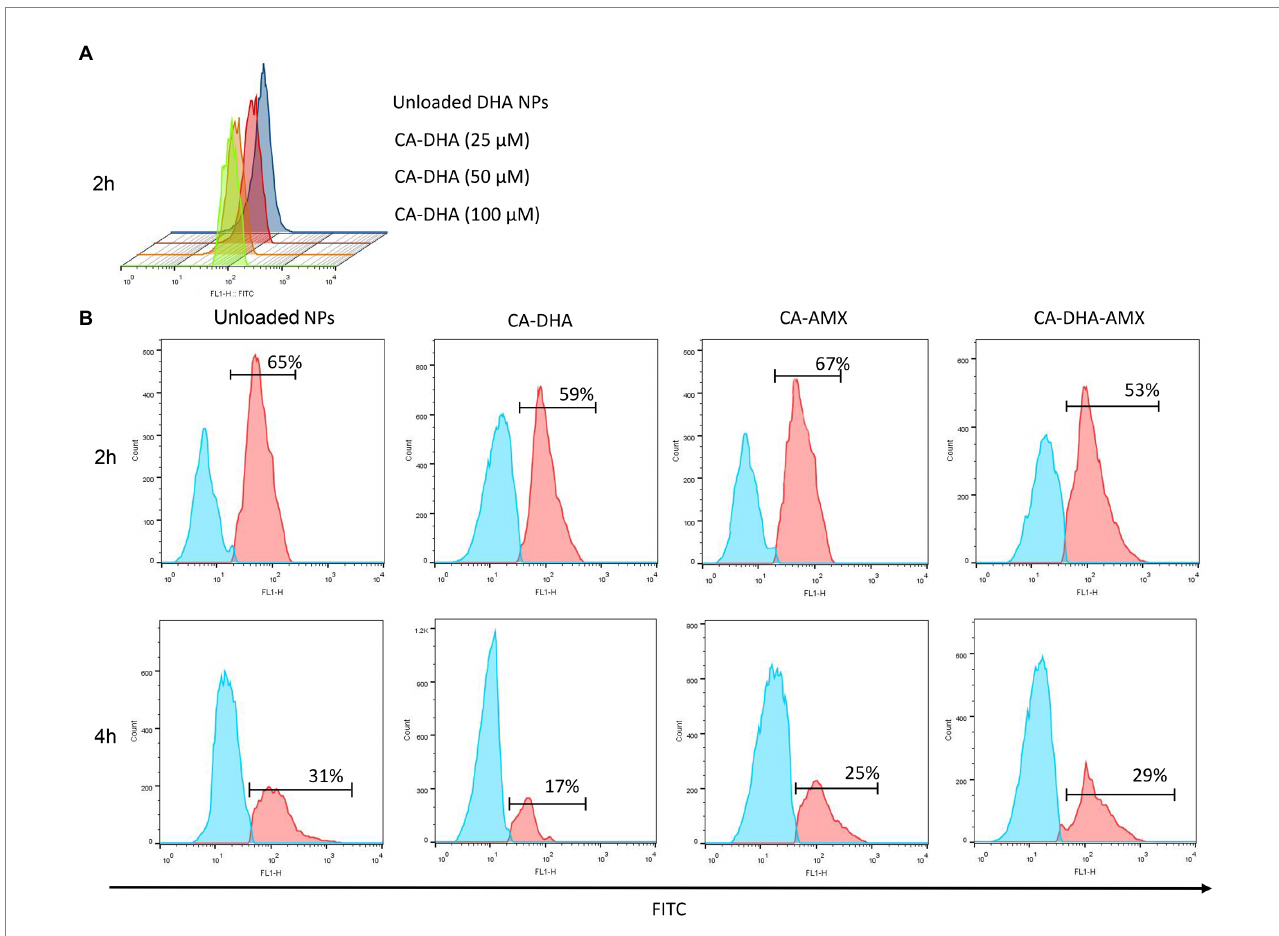
FIGURE 4 The bacterial binding capacity of composite NPs. (A) Bacterial adhesion of CA-DHA NPs and unloaded NPs at different concentrations of DHA. (B) The effect of different formulations of NPs on bacterial adhesion at two different time intervals; 2 h and 4